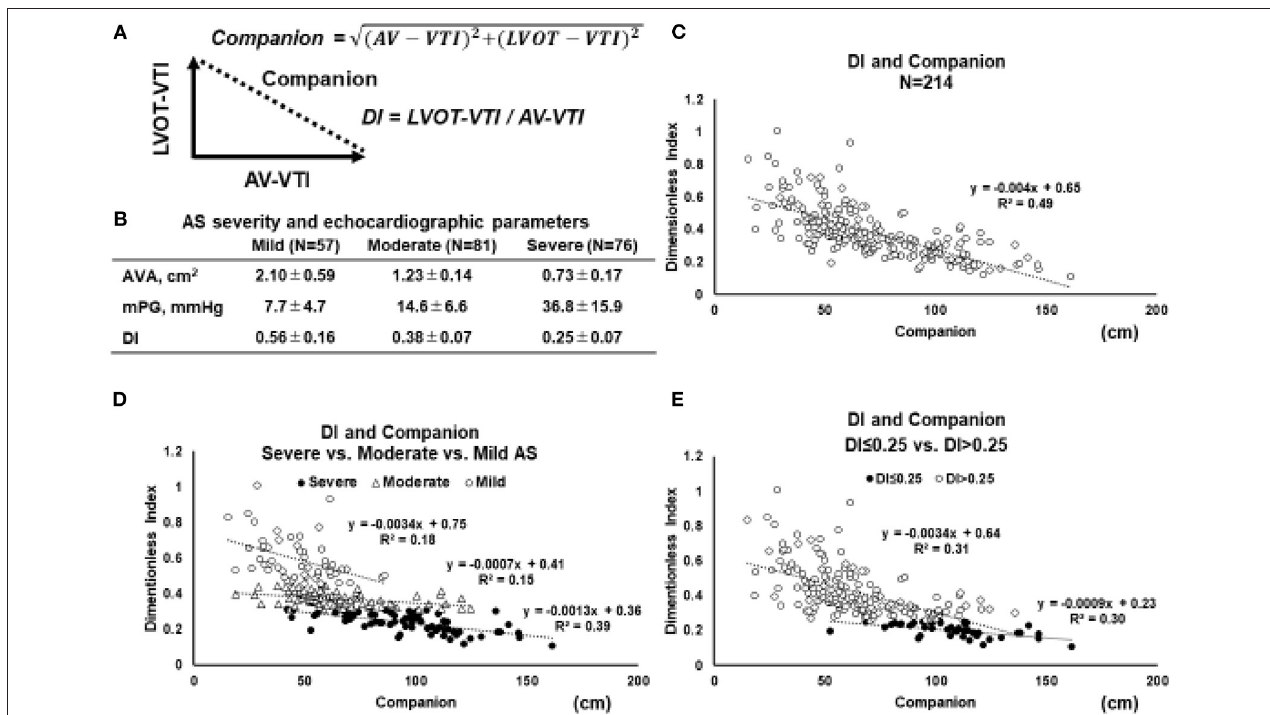
FIGURE 2 | Relation between DI and its companion. (A) Geometric relationship between the two parameters and the companion. Based on Pythagorean theorem, the companion (diagonal length of the triangle) is obtained by the following equation: Companion behavior of the relation between DI and companion, the echocardiographic parameters in 214 patients with AS are retrospectively reviewed. (C) The relations between the DI and companion in whole AS patients ( N severe). (E) The relation between the DI and companion in AS patients with DI